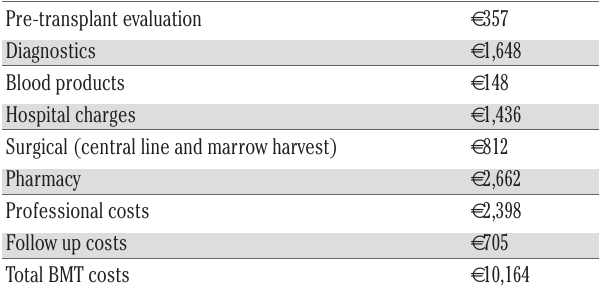
Table 1. Mean breakdown